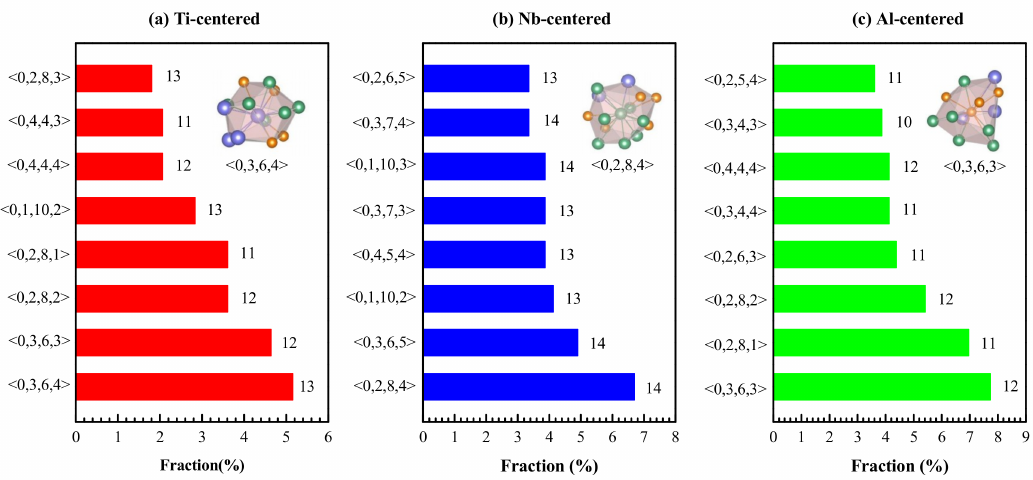
Figure 5. The distribution of Voronoi polyhedrons around Ti, Nb, and Al atoms in Ti 15 Nb 45 Al 40 glassy alloy. ( a ) Ti-centered; ( b ) Nb-centered; ( c )